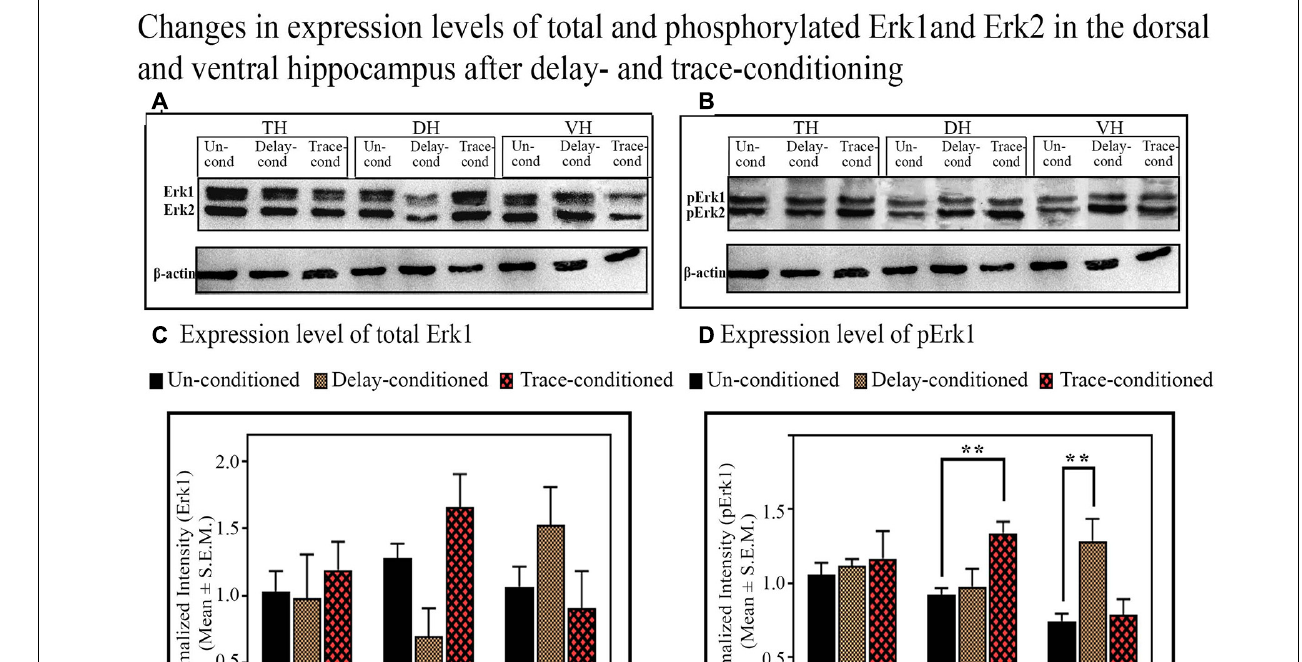
Frontiers in Cellular Neuroscience |